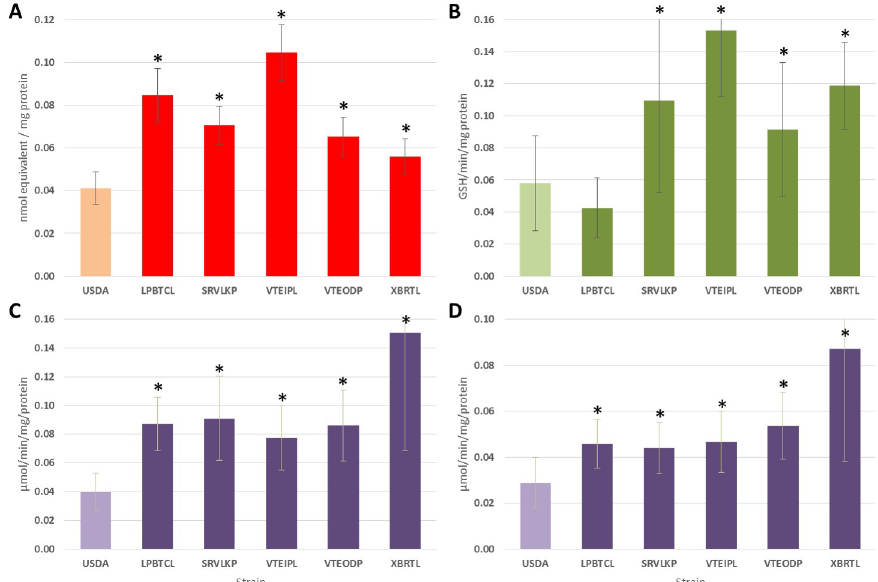
Fig 4. Activity of detoxification enzymes and 95% Confidence Interval in field caught Aedes aegypti populations in comparison to the susceptible reference strain (USDA): cytochrome P450 monooxygenases (P450s; A), Glutathione-S transferases (GSTs; B), Esterases ( α and β -CCEs; C and D). Sample sizes are 47 specimens/population. An asterisk ( � ) denotes significantly higher levels of detoxifying enzyme compared to the susceptible reference strain USDA.